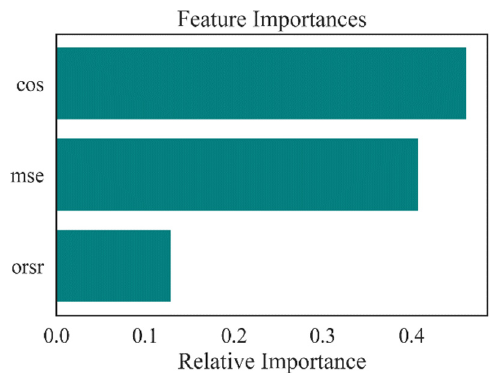
Figure 12. Permutation importance of the AE-based features.